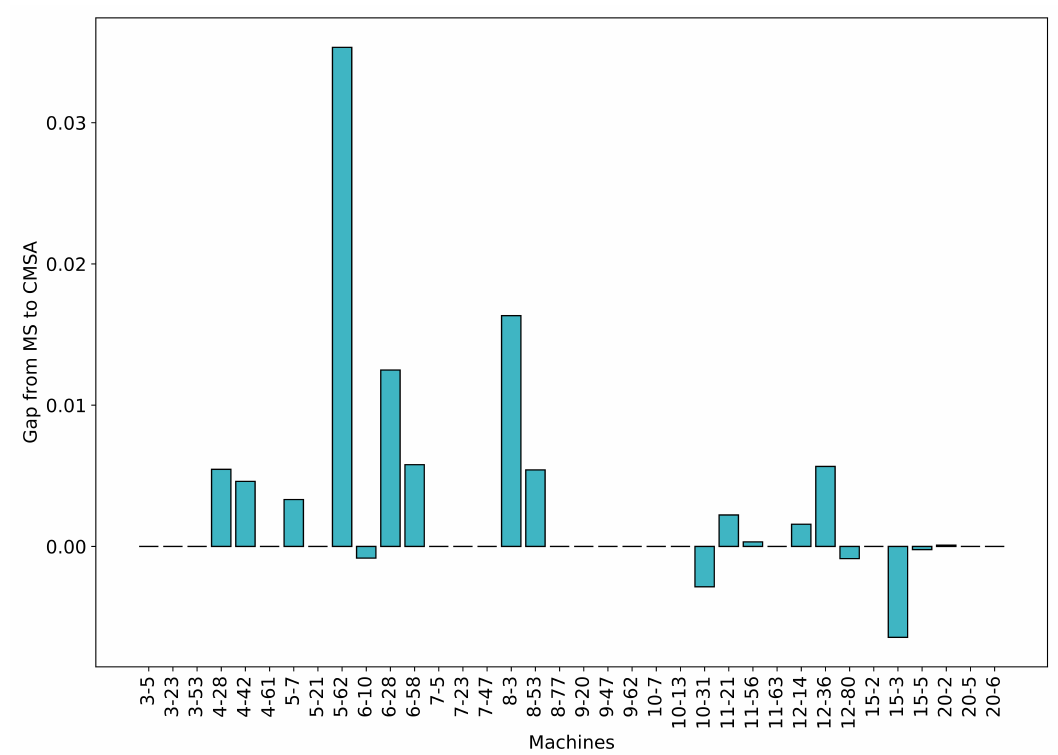
Figure 8. Comparing the solution quality obtained by MS and CMSA when they are provided with the same set of solutions for one iteration. The boxes show the improvement in MS over CMSA (in percent), with a positive value indicating that CMSA performed